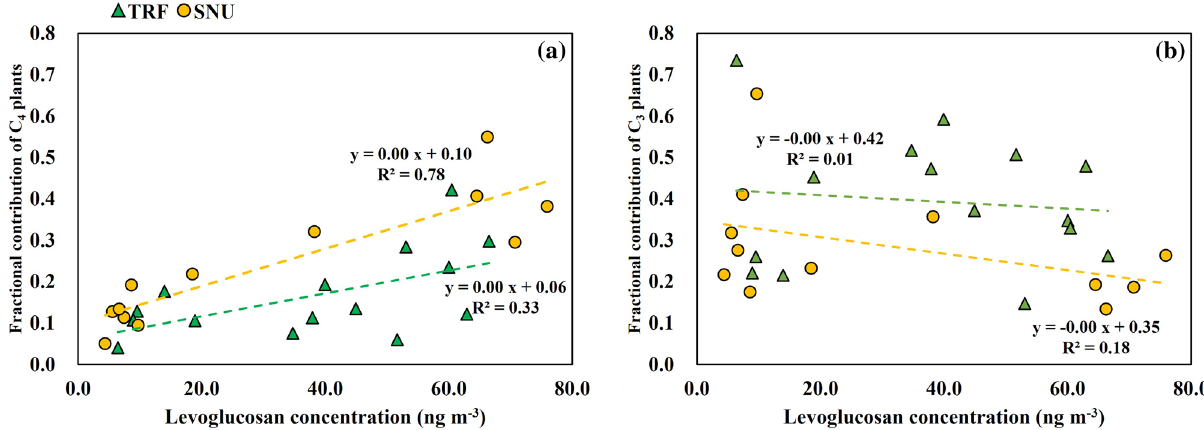
Figure 4. The correlation between the concentration of levoglucosan and the fractional contribution of ( a ) C 4 plants, and ( b ) C 3